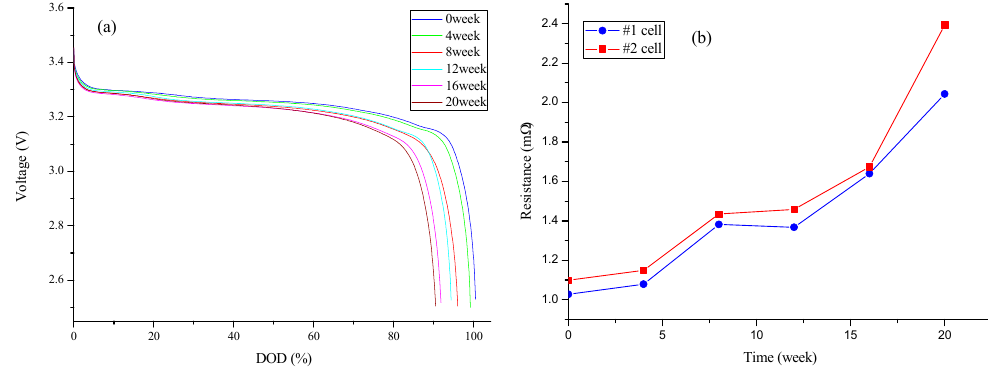
Figure 4. ( a ) Discharge curve of different week range at C/3 rate; and ( b ) resistance increase with duty cycles time for the #1 and #2 cells.